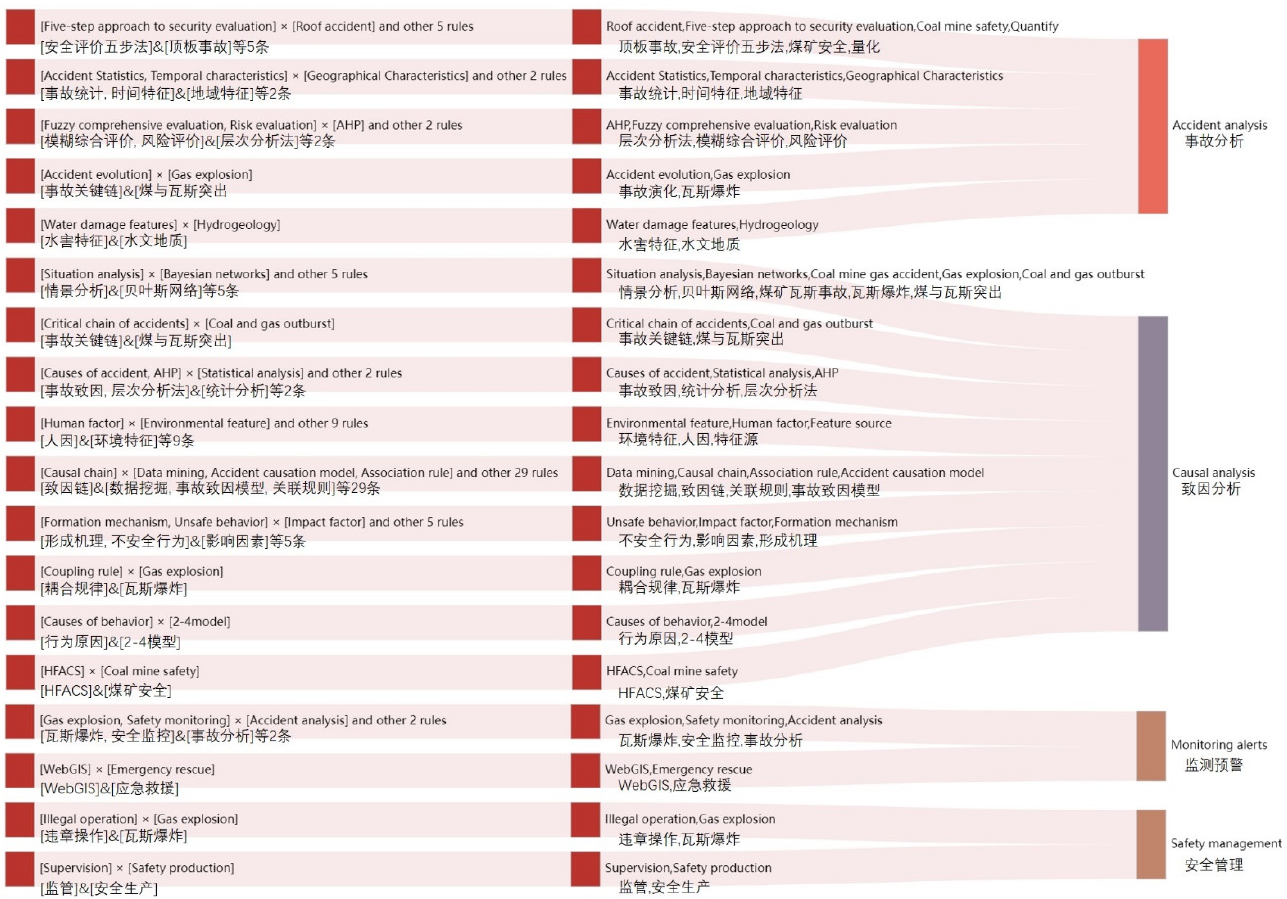
Table 4. Topic and top term of occupational injuries.